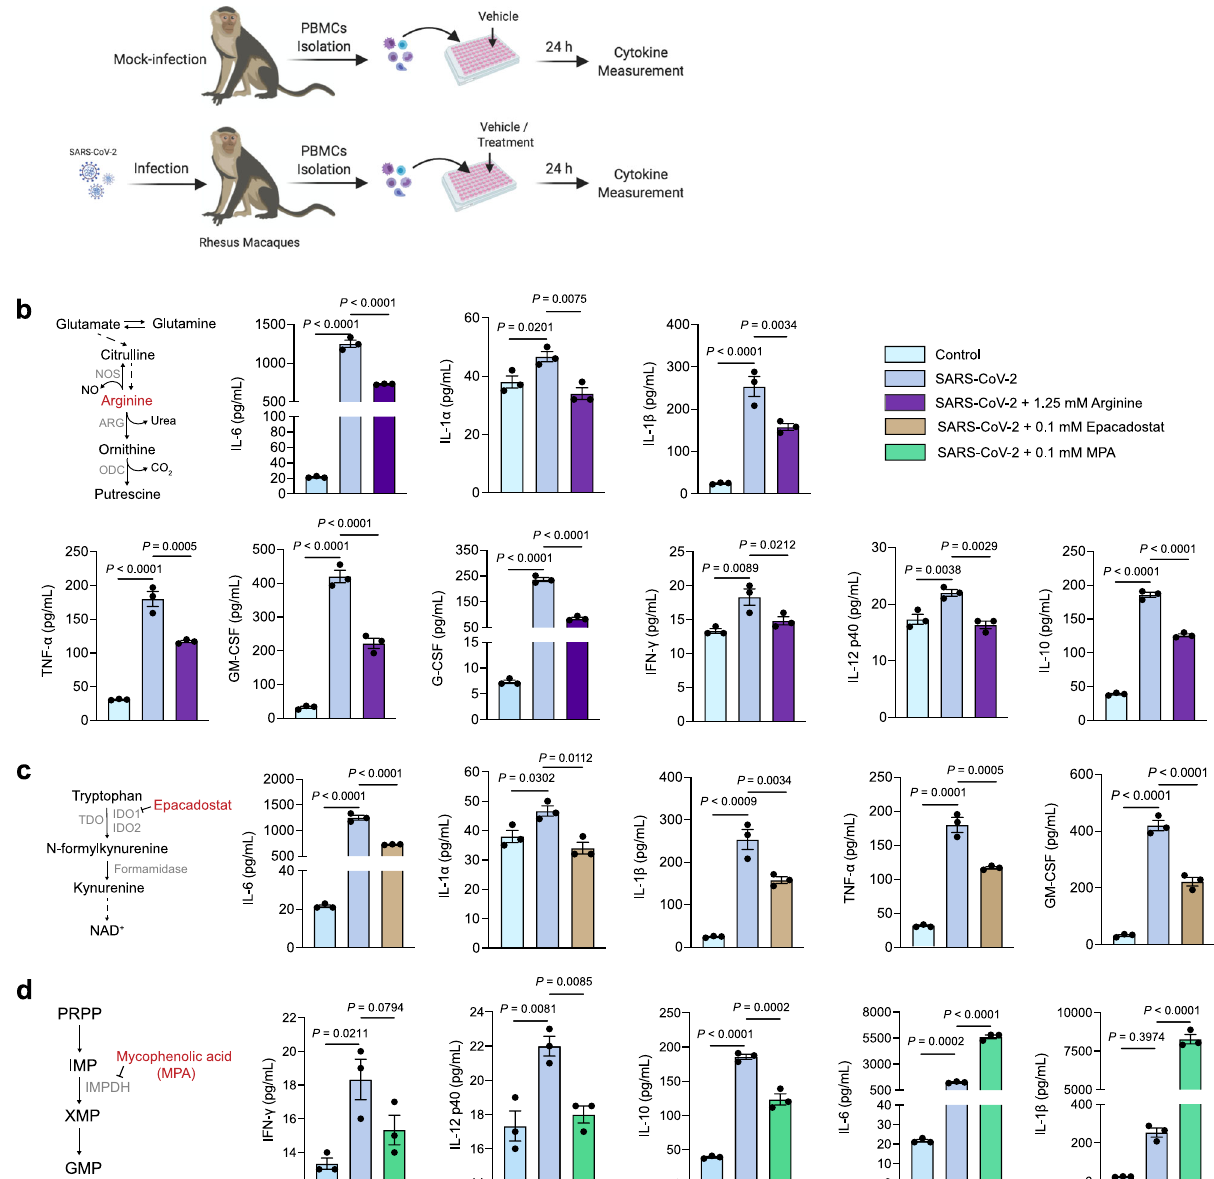
Fig. 4 Targeting metabolism modulates cytokine release in PBMCs ex vivo model. a Schematic representation of the experimental work fl ow. PBMCs, isolated from peripheral blood of the mock-infected and SARS-CoV-2-infected rhesus macaques, were seeded in 96-well plates with vehicle or different drugs dissolved in medium; 24 h post-seeding, cytokine abundance in cell culture was quanti fi ed. b – d Metabolism diagrams and level of indicated cytokines and chemokines measured 24 h after supplementation of 1.25 mM arginine ( b ), 0.1 mM IDO1 inhibitor Epacadostat ( c ), and 0.1 mM inosine monophosphate dehydrogenase (IMPDH) inhibitor mycophenolic acid (MPA, d ) in PBMCs ( n = 3). Data are presented as mean ± SEM. with individual data points shown. One-way ANOVA followed by Benjamini-Hochberg (BH) multiple comparison